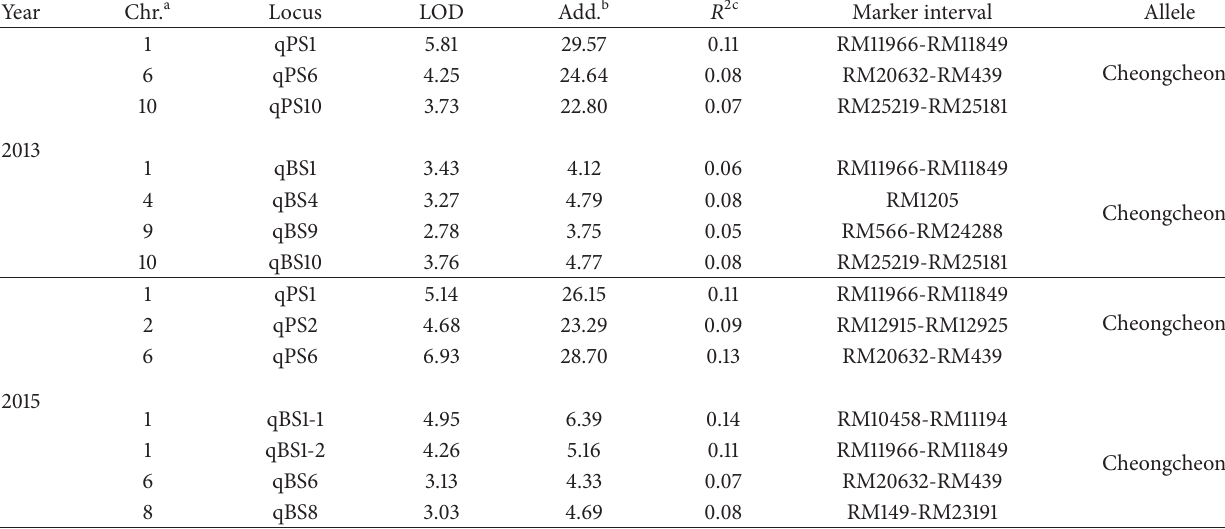
Table 3: The QTL analysis related to pulling and bending strength in 2013 and 2015. Add. b 𝑅 2 c Marker interval